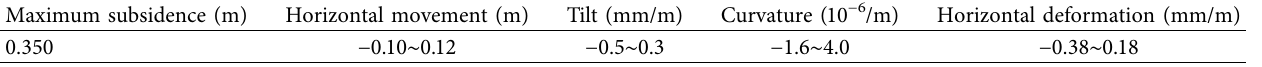
Table 2: Surface movement and deformation